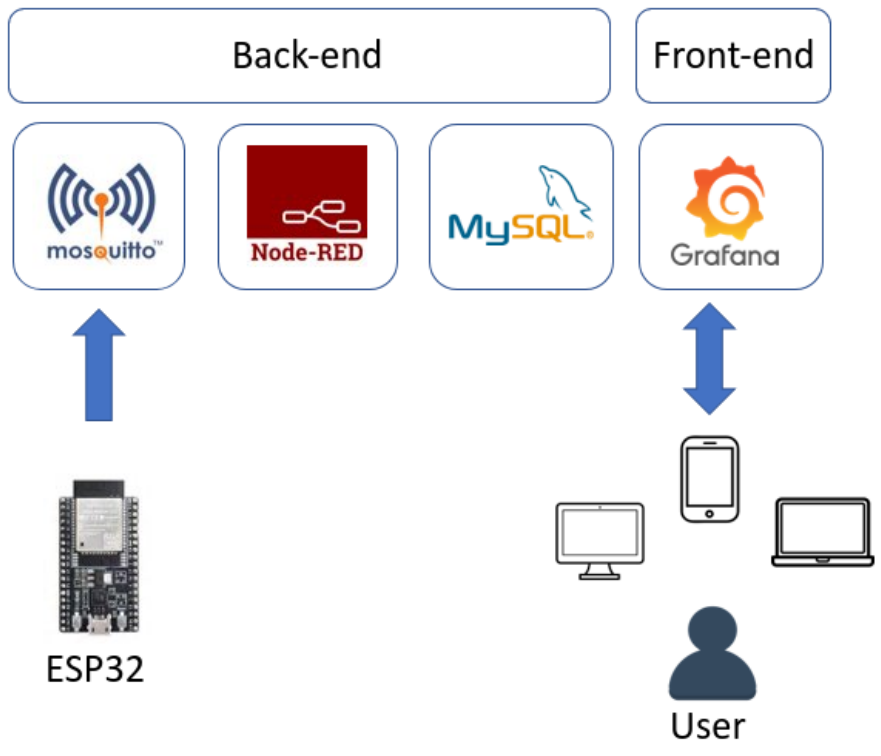
Figure 1. Application architecture.